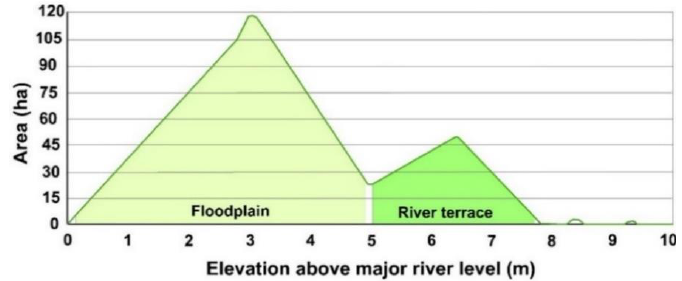
Figure 8. Non-accumulated hypsometric curve of VDCN mod for areas classified as “flat land” based on the slope